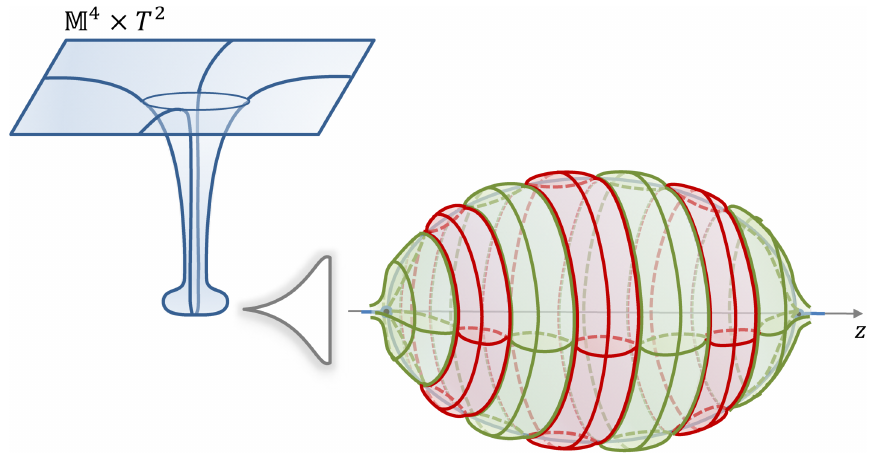
Figure 3. Schematic description of a Weyl star spacetime. The T 2 circles are colored in red and green. The S 2 at the surface of the star is recovered by axisymmetric microscopic bubbles (7 in the figure) where one of the T 2 circles shrink